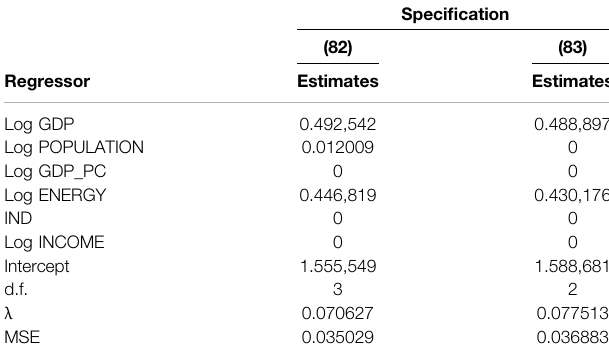
TABLE 2 | Descriptive statistics. Variable